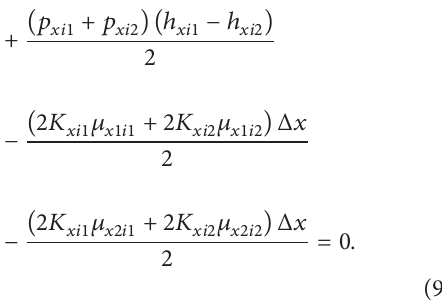
(3)-(4) of current values for plastic friction coefficient values 𝜇 𝑥2